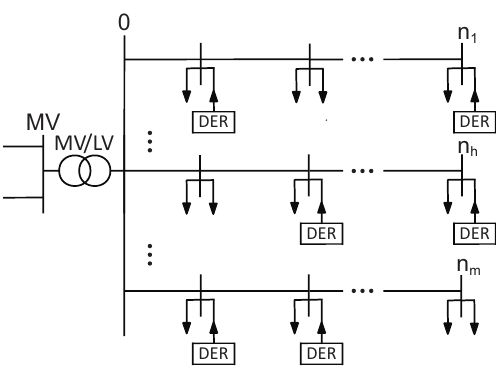
Figure 1. Low Voltage distribution system with Distributed Energy Resources.